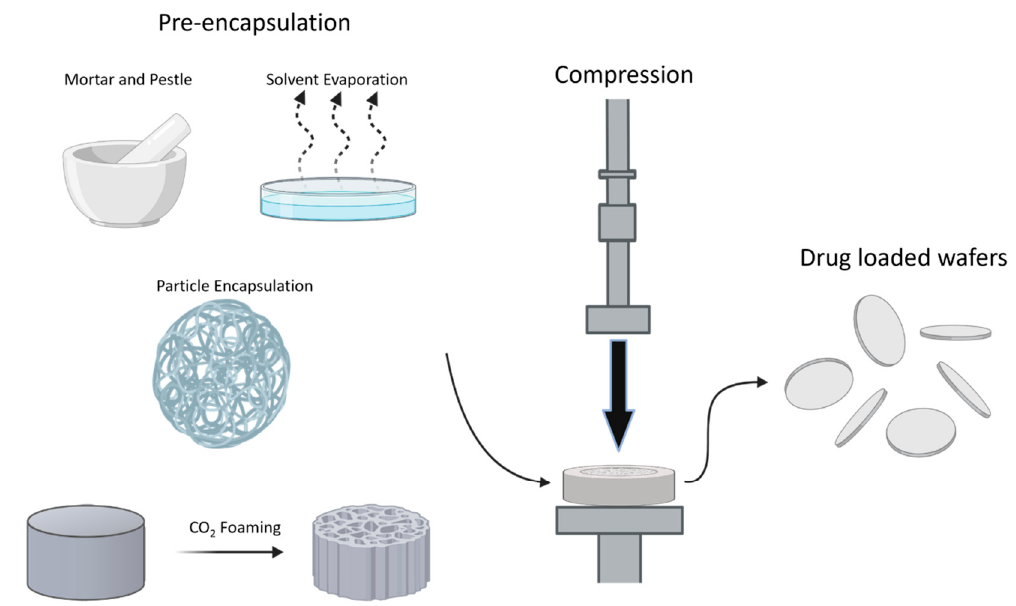
Figure 4. A schematic of fabricating drug-loaded wafers through compression molding where the pre-encapsulation methods used are using a mortar and pestle, solvent evaporation, encapsulating the drug in a particle, or creating a foam using supercritical CO 2 foaming.